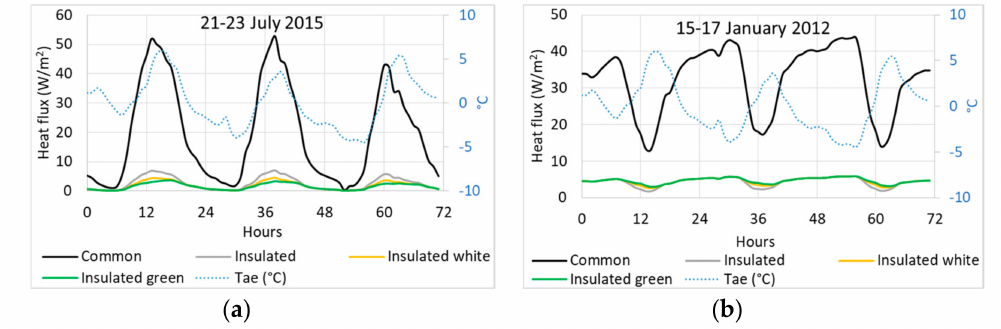
Figure 14. Comparison of hourly heat fluxes (W / m 2 ) between common roof, insulated common roof, insulated high-reflectance roof, and insulated green roof for three consecutive days: ( a ) 21–23 July 2015; ( b ) 15–17 January